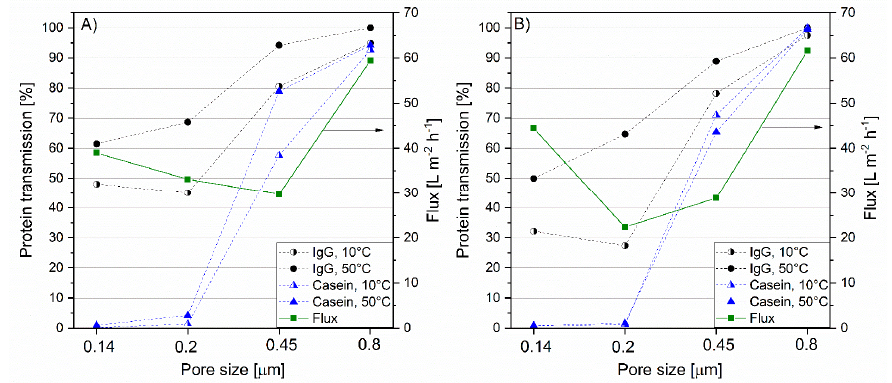
Figure 6. IgG and casein transmission plus flux as a function at 10 °C and 50 °C at Δ p TM = 1 bar ( A ) and Δ p TM = 2 bar ( B ) as a function of pore size at steady state conditions using gradient membranes. Arrows indicate the belonging of the flux curve to the right y-axis. For equivalent β -Lg and time-dependent data, see the Supplementary Information.